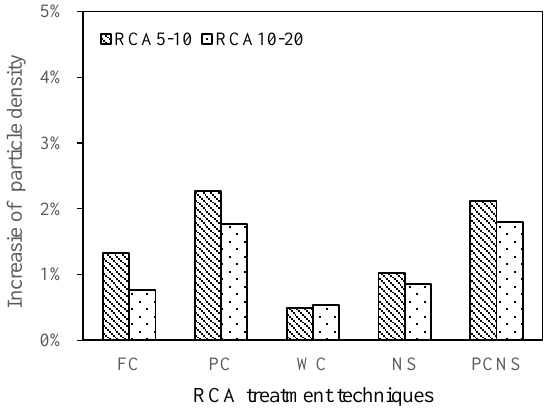
Figure 2. Increasing rate of particle density of RCA.